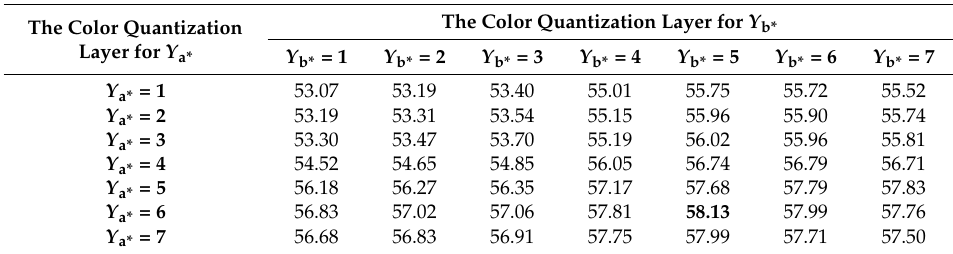
Table 3. Average precision rate (APR) of different color quantization layers on Outex-00013. The Color Quantization Layer for Y a*